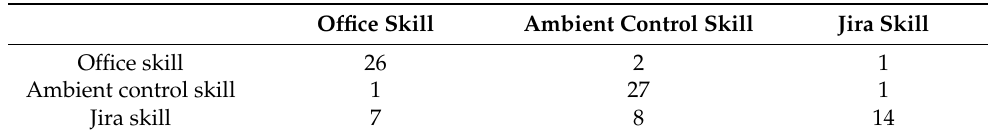
Table 6. Confusion matrix for the three